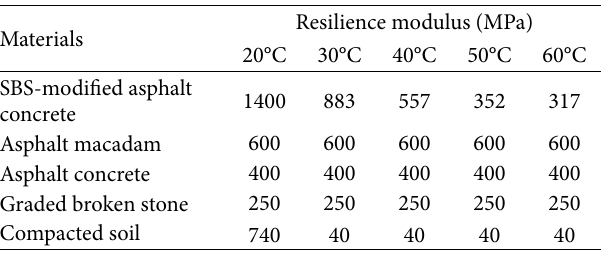
Table 3: Resilience modulus of asphalt mixtures at different tem- peratures.